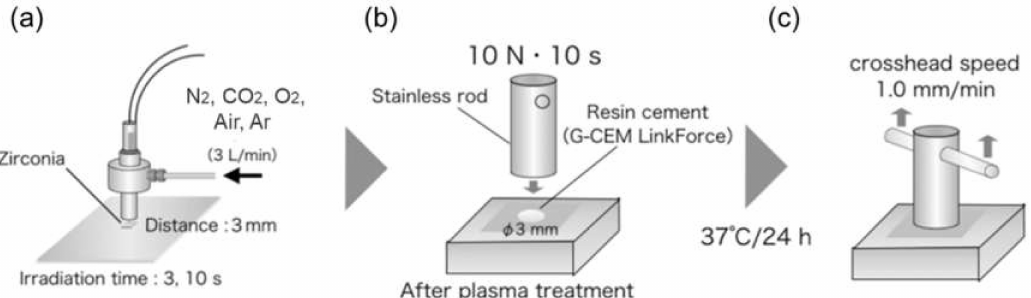
Figure 1. Procedure for evaluating tensile bond strength: ( a ) An atmospheric low-temperature multi-gas plasma jet was used for zirconia surface treatment. ( b ) After zirconia surface treatment, all zirconia specimens were immediately bonded to stainless rods using dental adhesive resin cement. The bond area was circular, with a diameter of 3 mm. ( c ) The bond strength was measured using a universal testing